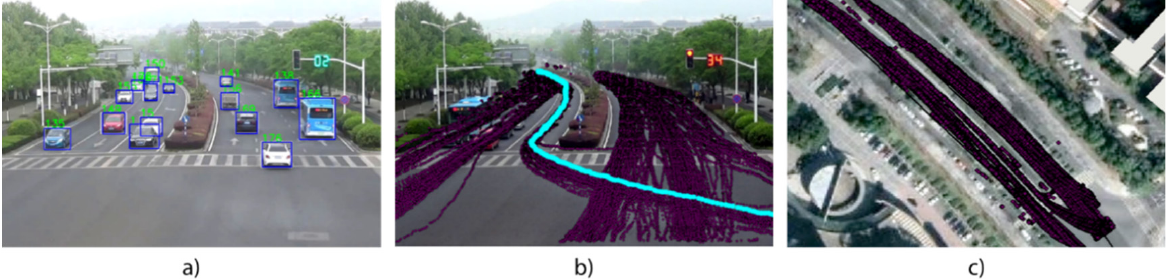
Figure 8. Traffic analysis for road R1 based on road surveillance video data. ( a ) Vehicle detection in one frame of video, ( b ) vehicle trajectories and the highlighted points of one vehicle and ( c ) overlay of vehicle trajectories and a remote sensing image.